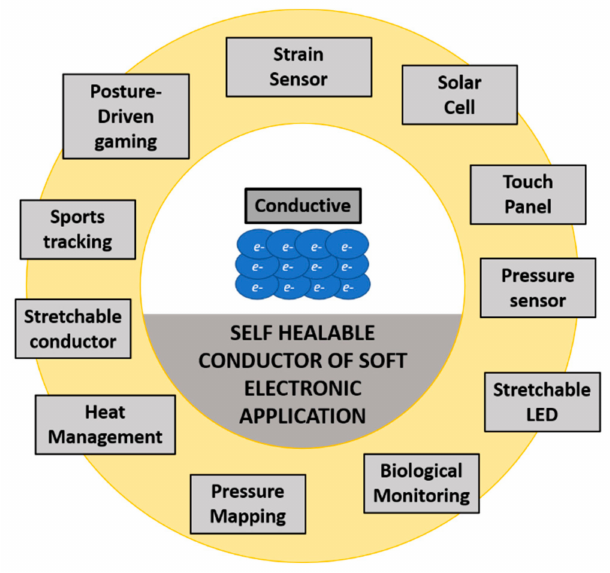
Figure 5. Soft electronic